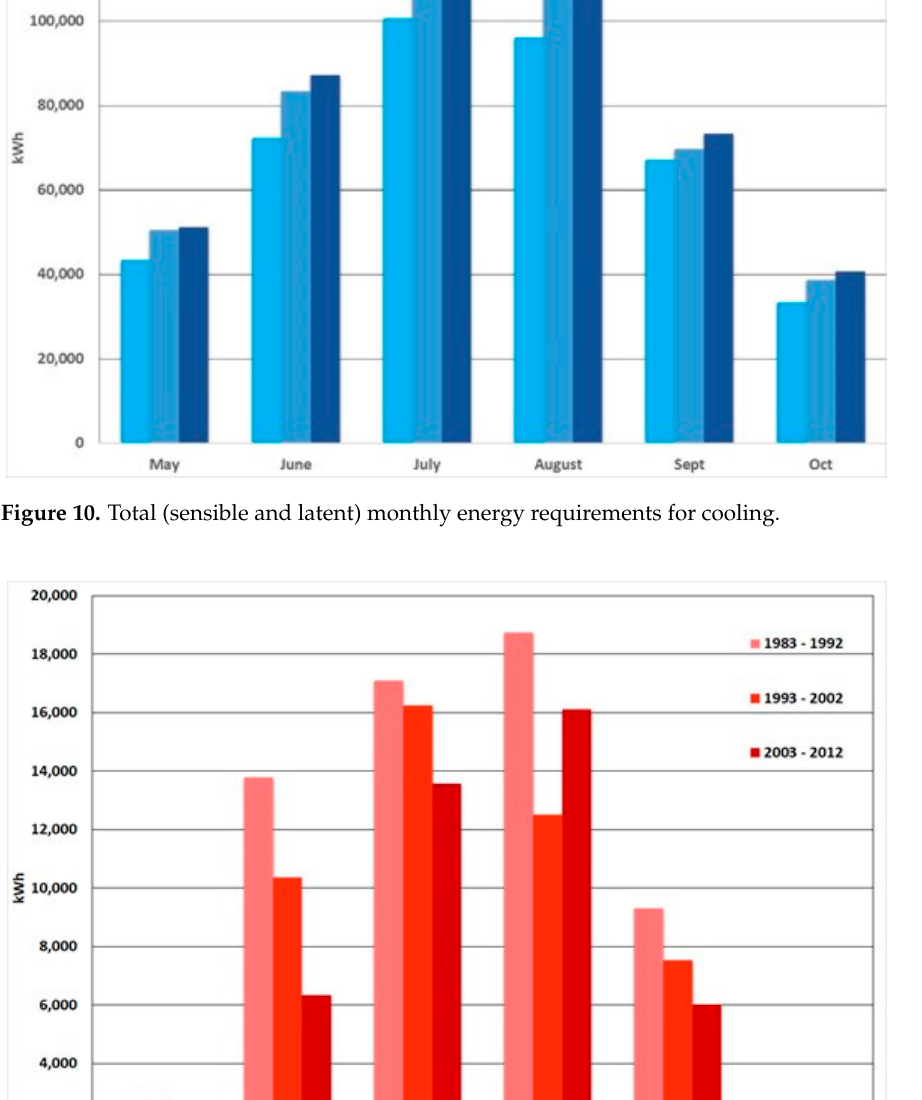
Table 7. Latent and sensible loads for the 1983–2013